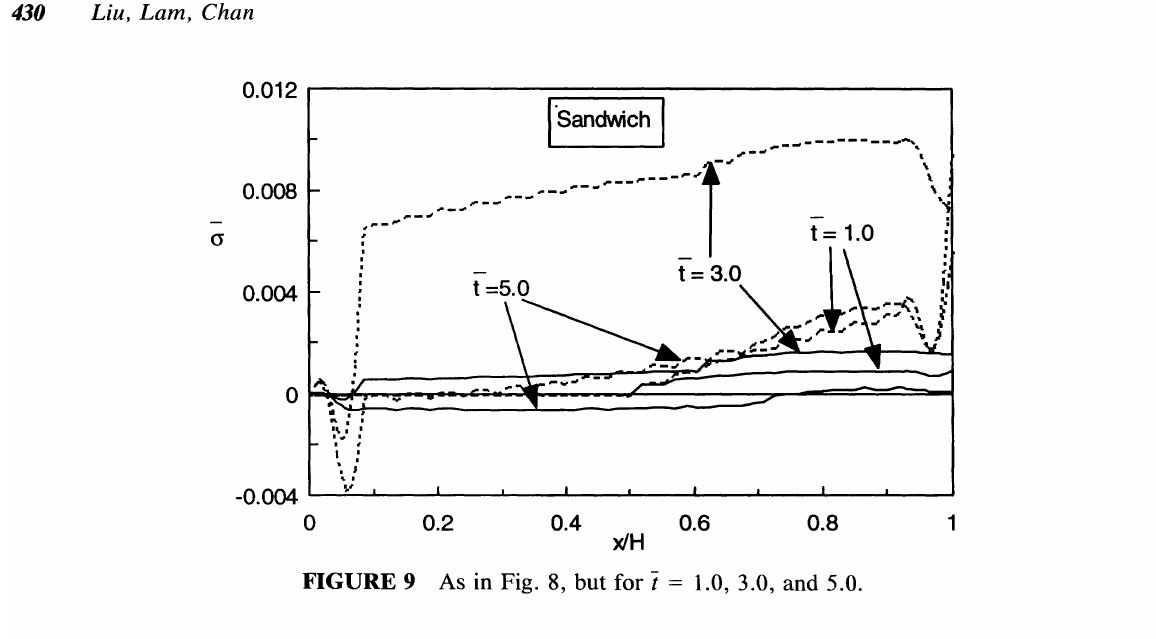
FIGURE 9 As in Fig. 8, but for t = 1.0, 3.0, and 5.0.